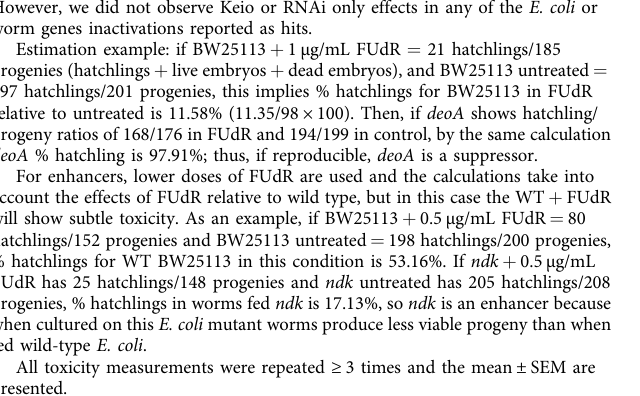
Supplementary Table 2 as: blue = suppressor of toxicity; orange = enhancer of toxicity. Light blue or orange, represents phenotype observed in only 1 of screen 3 repeats. Hits belonging to overrepresented metabolic pathways were retested in 6 cm NGM plates and quantitated for % hatchlings in sublethal FUdR (0.25 µg/mL) ± serine (1.5mg/mL), and the results are presented in main fi gures. Primary screen hits that were not retested in 6cm plates are depicted as NRT in Supplementary Table 2. Retested and veri fi ed hits and non-hits are marked as “ √ ” , and retested but not validated primary hits (phenotype did not repeat) are marked as “ X ” . Bacterial growth in plate . E. coli BW25113 and HB101 were cultured and seeded in NGM ± additives plates as normally done for Lth-FUdR or SE-FUdR tests. After 48 h exposure to treatments, cells were recovered from the plates, resuspended in equal volumes, and biomass (OD 600nm ) and viability (CFU of serial dilutions from 10 0 to 10 − 7 ) were